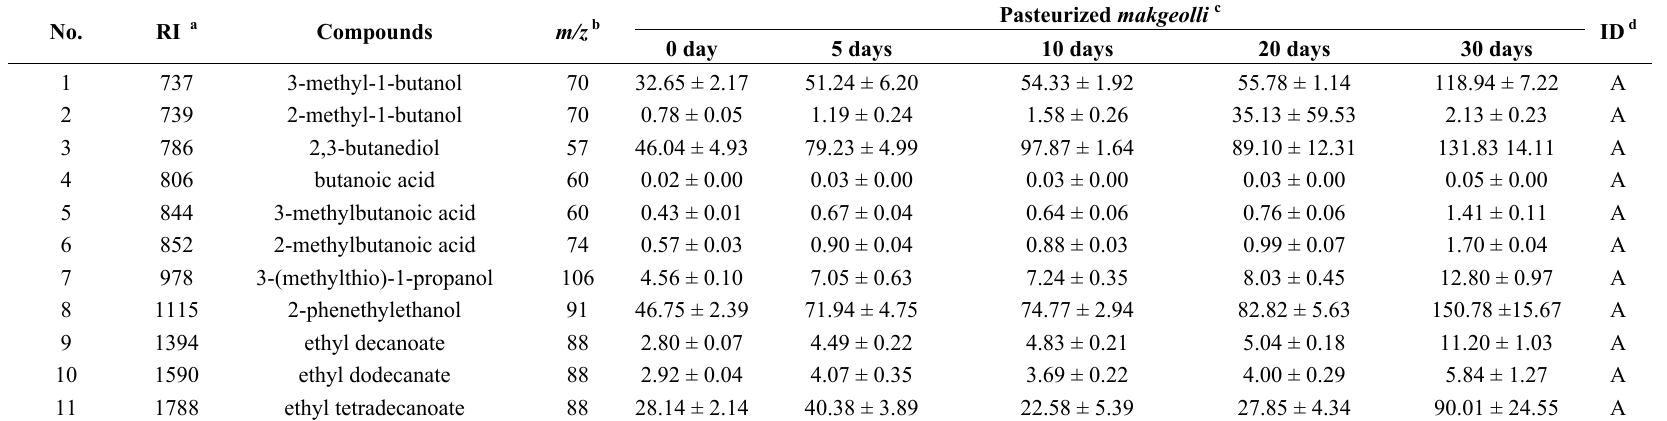
Table 3. The concentrations of odor-active compounds in pasteurized makgeolli during